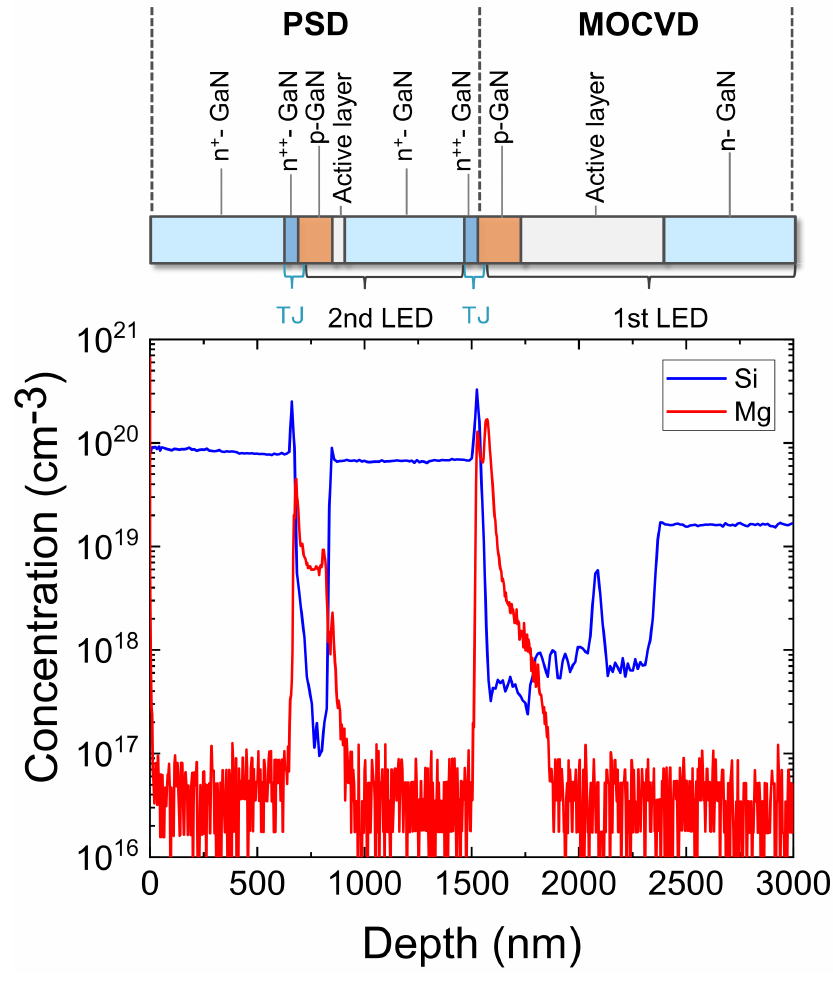
Figure 3. SIMS profile of Si and Mg in the LED stack with the tunneling